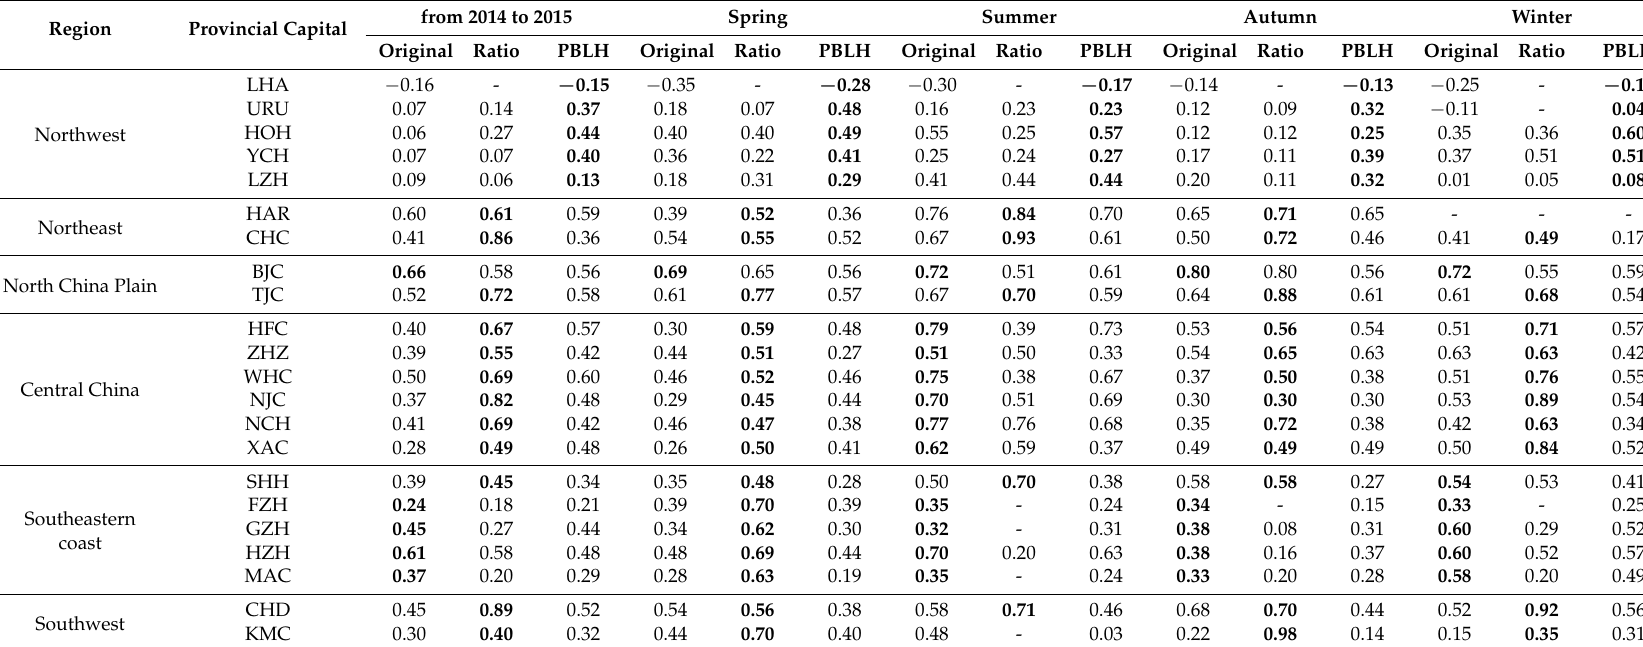
Table 2. The seasonal Pearson correlation coefficient (R) of PM 2.5 and Original satellite-derived AOD, Revised AOD by CALIOP ratio, Revised AOD by PBLH. The optimal values of Pearson correlation coefficient were bolded. Spring includes March, April and May; summer includes June, July and August; autumn includes September, October and November; and winter includes December, January and